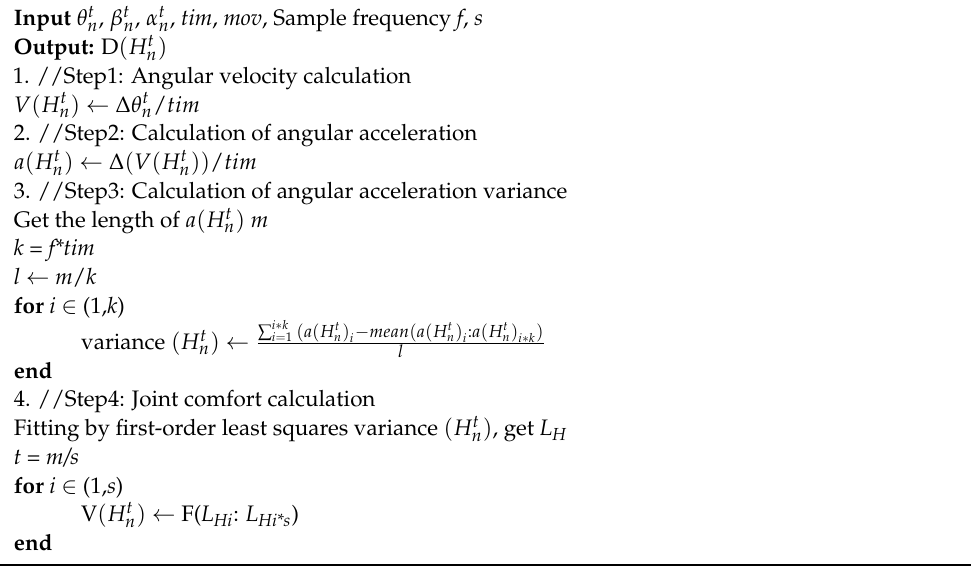
Algorithm 2: Lower extremity joint angular velocity variance comfort index